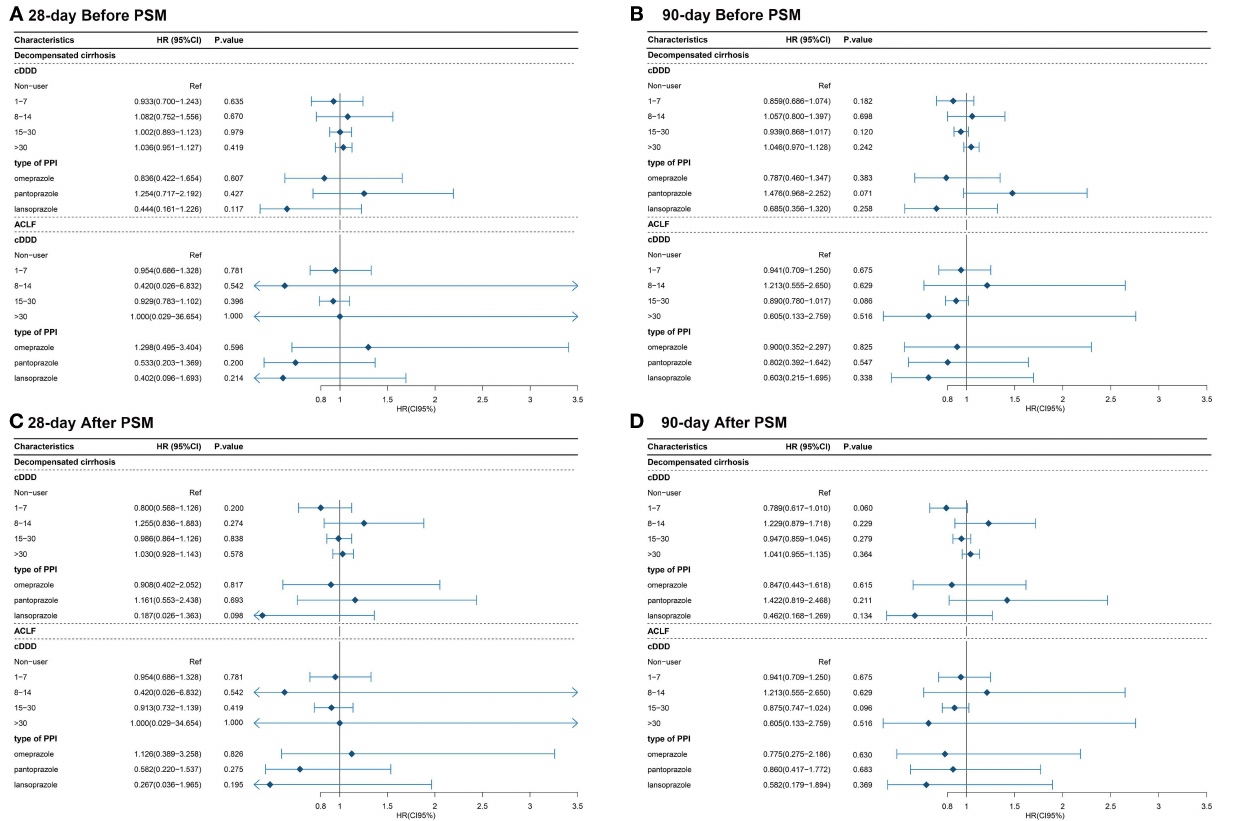
FIGURE 4 | The relationship between the type and dose of the PPI therapy and 28-day and 90-day mortality (A) The relationship between the type and dose of the PPI therapy and 28-day mortality before PSM; (B) The relationship between the type and dose of the PPI therapy and 90-day mortality before PSM; (C) The relationship between the type and dose of the PPI therapy and 28-day mortality after PSM; (D) The relationship between the type and dose of the PPI therapy and 90-day mortality after PSM. cDDD, cumulative defined daily dose; PPI, proton pump inhibitor; ACLF, acute-on-chronic liver failure.